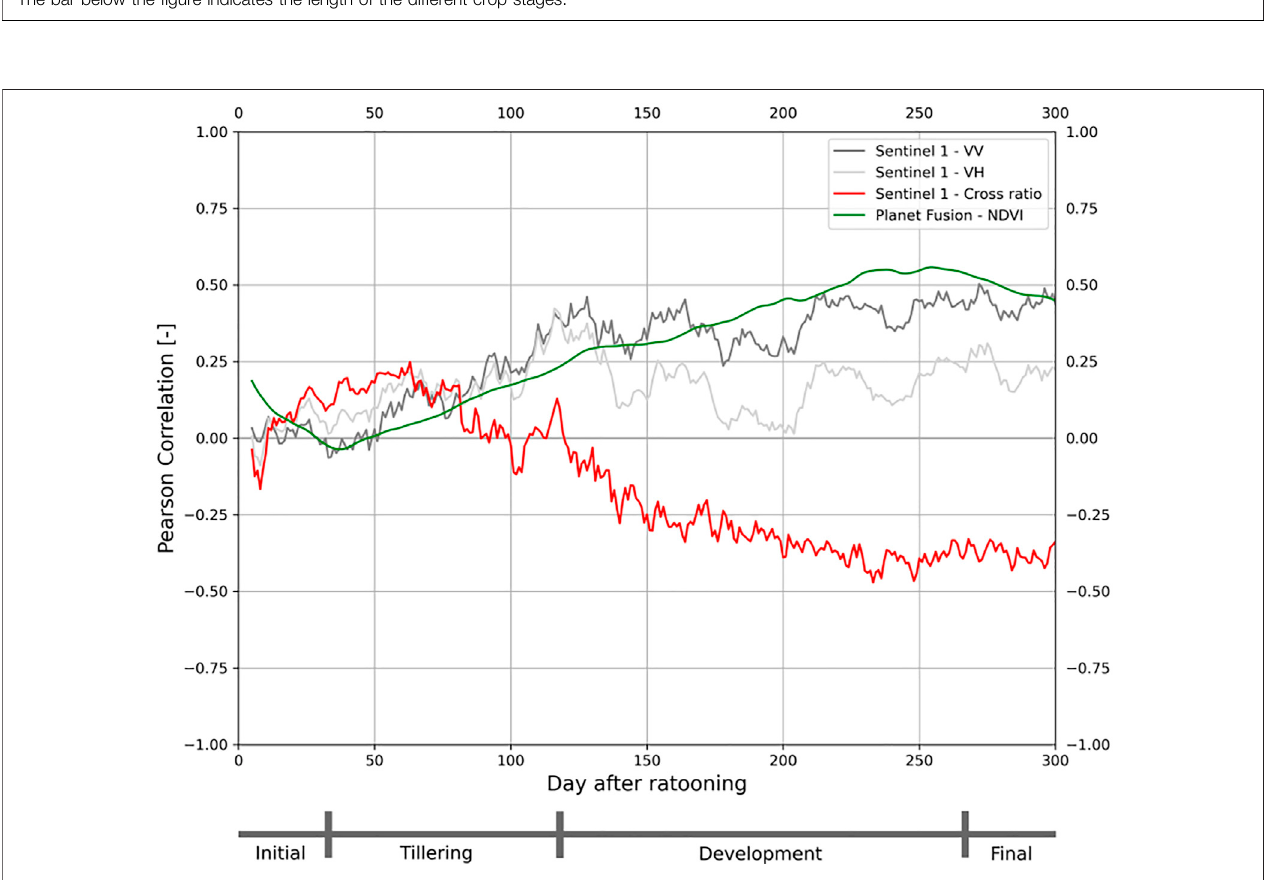
FIGURE 3 | Pearson correlation with sugarcane yield for season 2019-2020 for VV and VH polarization, Cross ratio, and NDVI. The bar below the fi gure indicates the length of the different crop stages.